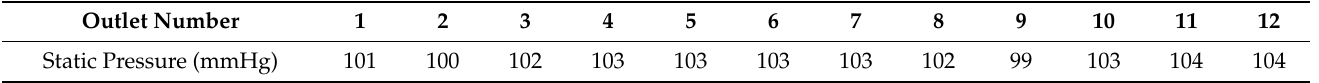
Table 1. Mean pressure of the arterial branch end surface, based on clinical measurements. Outlet Number